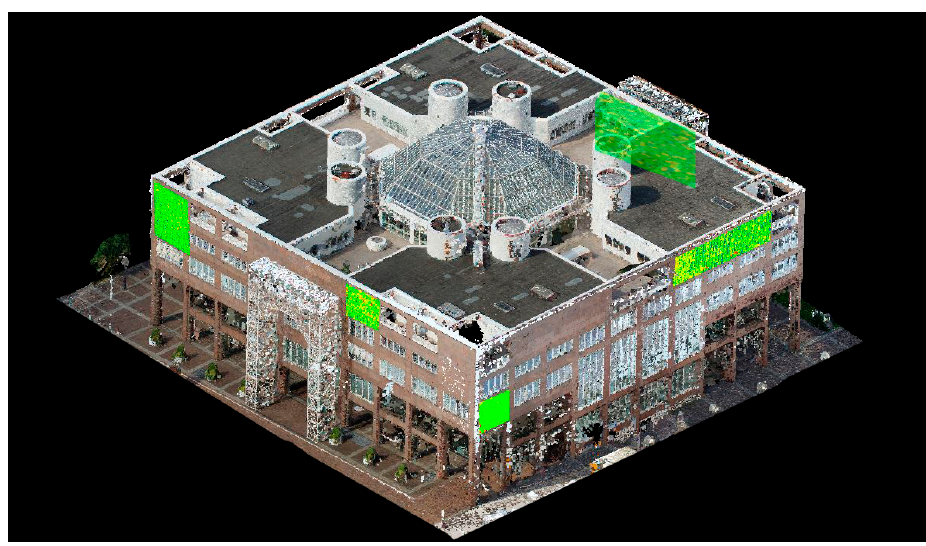
Figure 16. Selected five areas for cloud-to-cloud distance analyses between the laser scanning ground truth and the two photogrammetric clouds. Table 17. Results of the cloud-to-cloud distance analyses on the original and filtered dense clouds and average variation of the mean values.